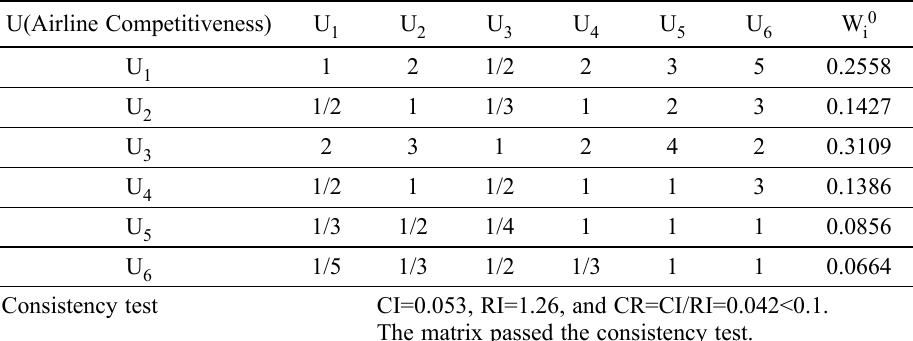
Table 3. U-Um comparison matrixes and relevant data